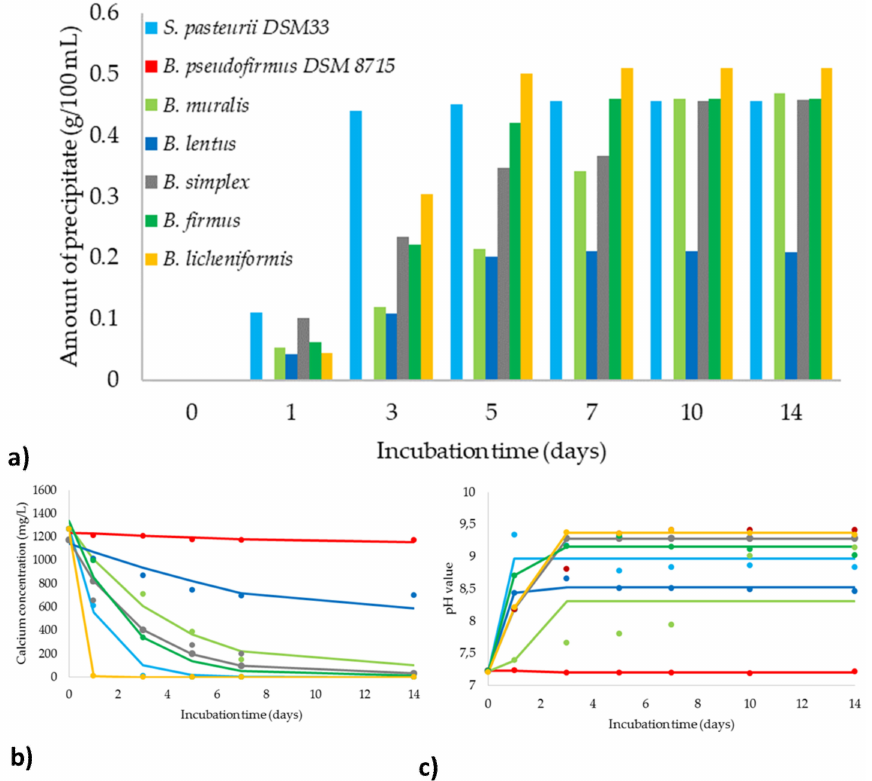
Figure 5. Evaluation of MICP process: ( a ) amount of precipitate; ( b ) pH monitoring; ( c ) calcium concentration (for ( b , c ) markers signify the experimental data; lines indicate predictive